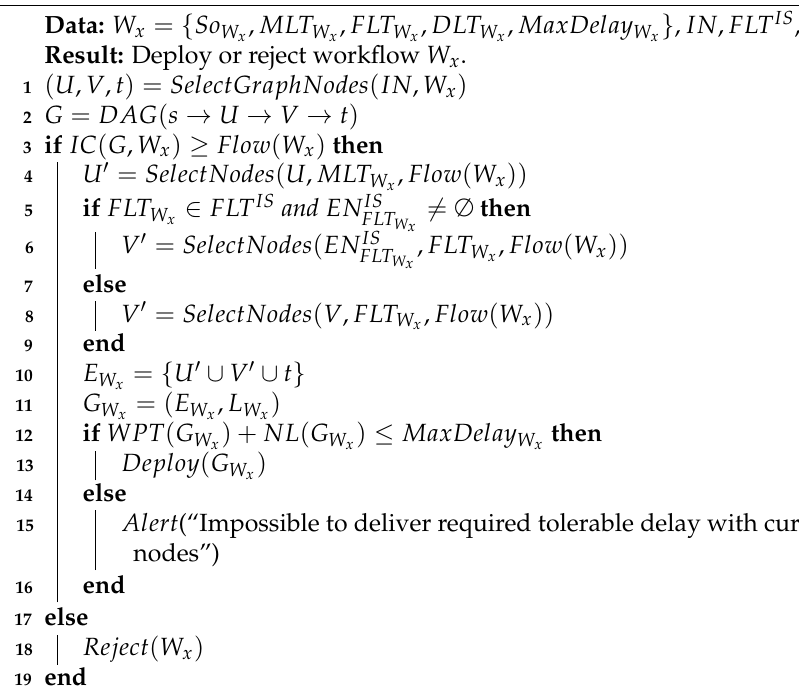
Algorithm 1: Orchestrator workflow